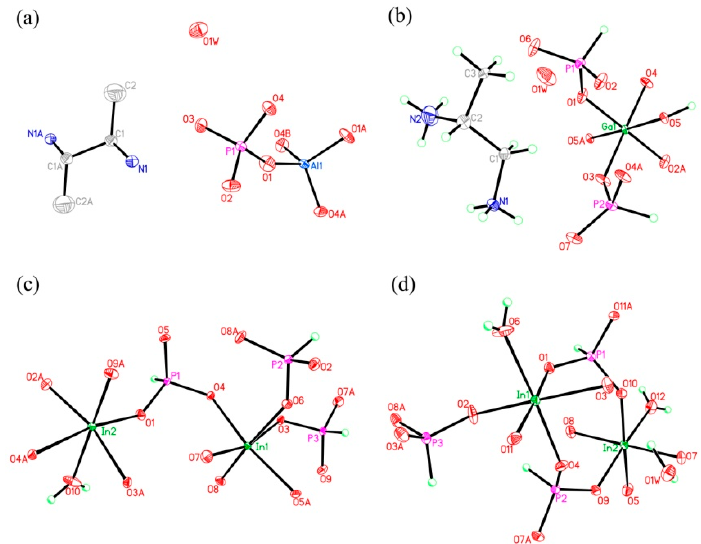
Figure 4. The atomic labelling schemes and thermal ellipsoid plots (30%) of compound ( a ) 1 , ( b ) 2 , ( c ) 3 , and ( d ) 4 .